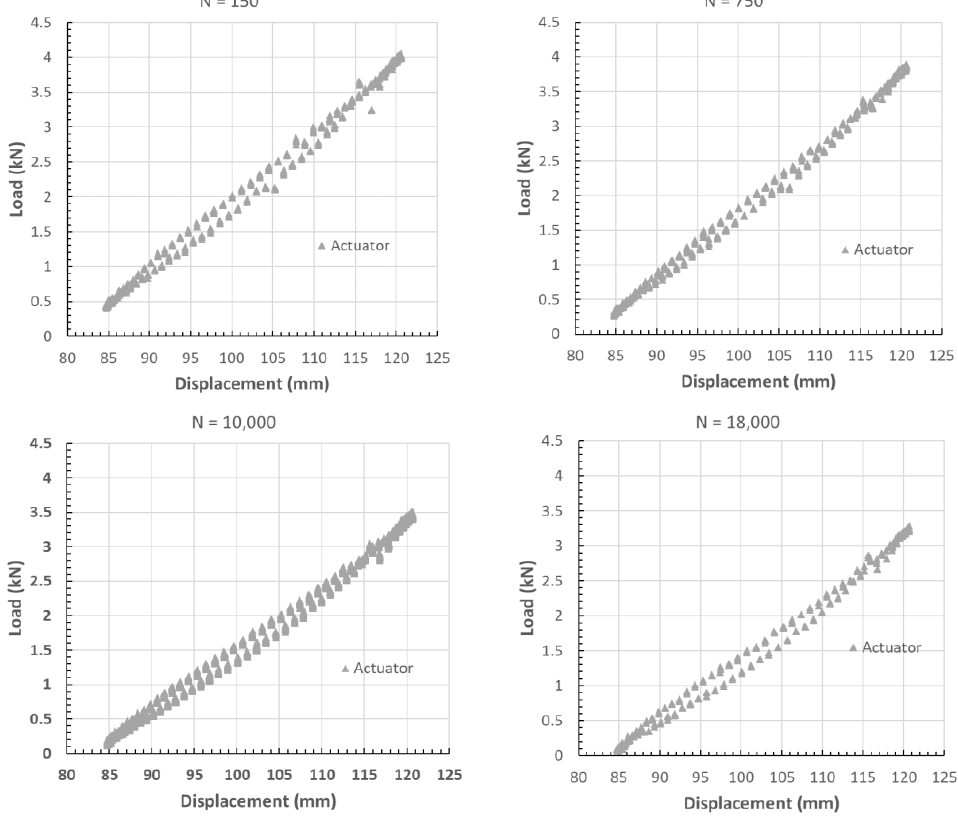
Figure 12. Load – displacement hysteresis curves at constant loading (T5). Figure 12. Load–displacement hysteresis curves at constant loading